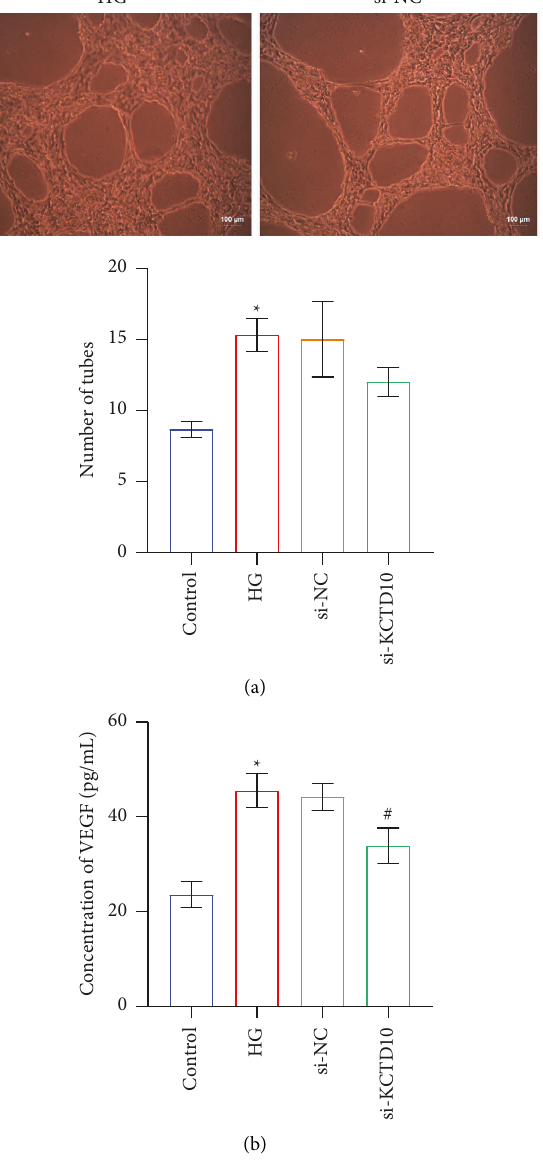
Figure 3: Inhibition of KCTD10 regulated HRECs angiogenesis. (a) The angiogenesis of cells was observed by tube formation assay. (b) VEGF expression of cells was observed by ELISA. ∗ P < 0 . 05 versus the control group. # P < 0 . 05, versus the si-KCTD10